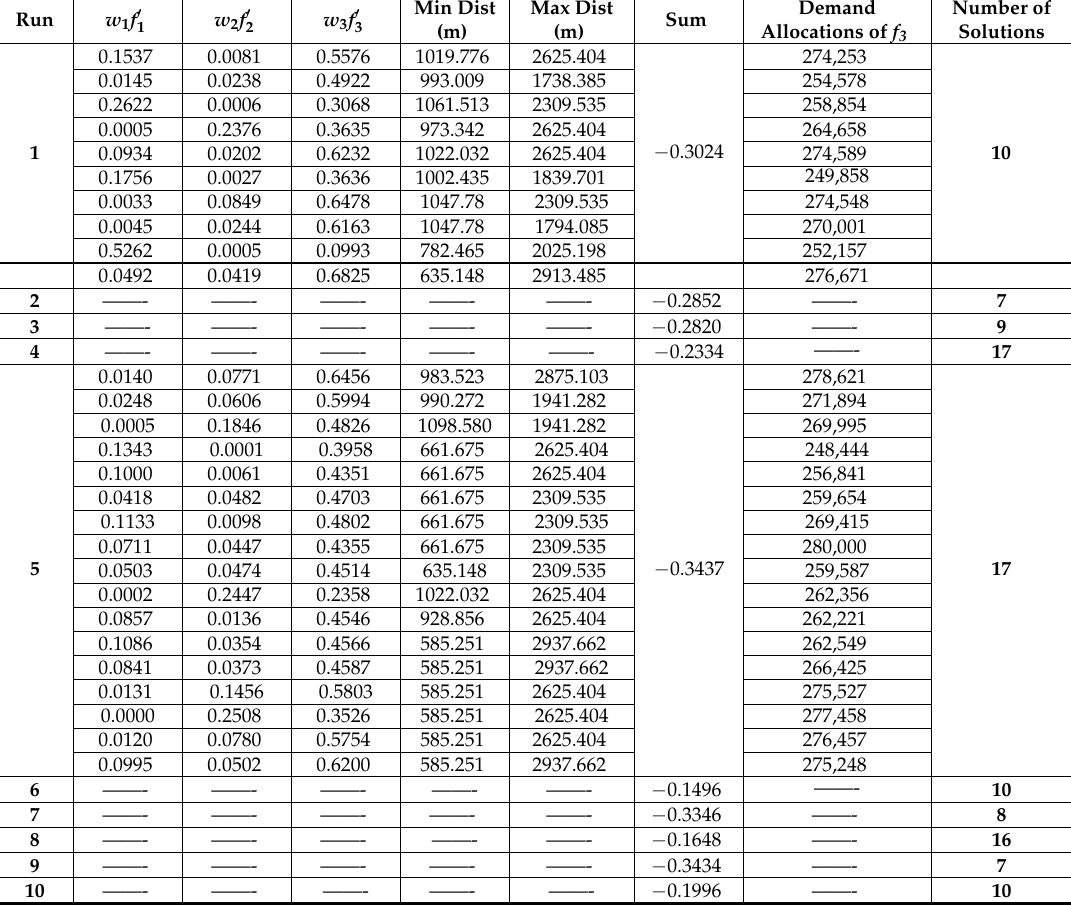
Table 5. Non-dominated solutions of 10 independent implementations with 150 iterations.